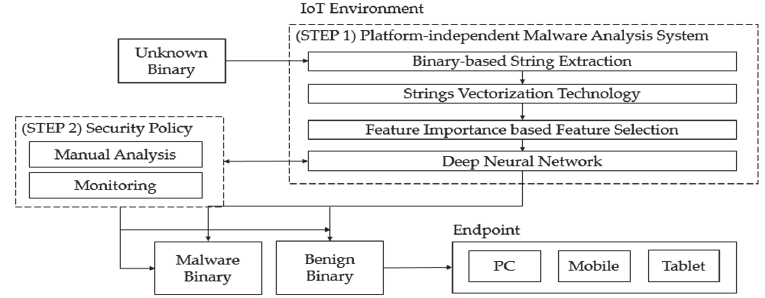
Figure 7. Platform-independent malware analysis overall system.